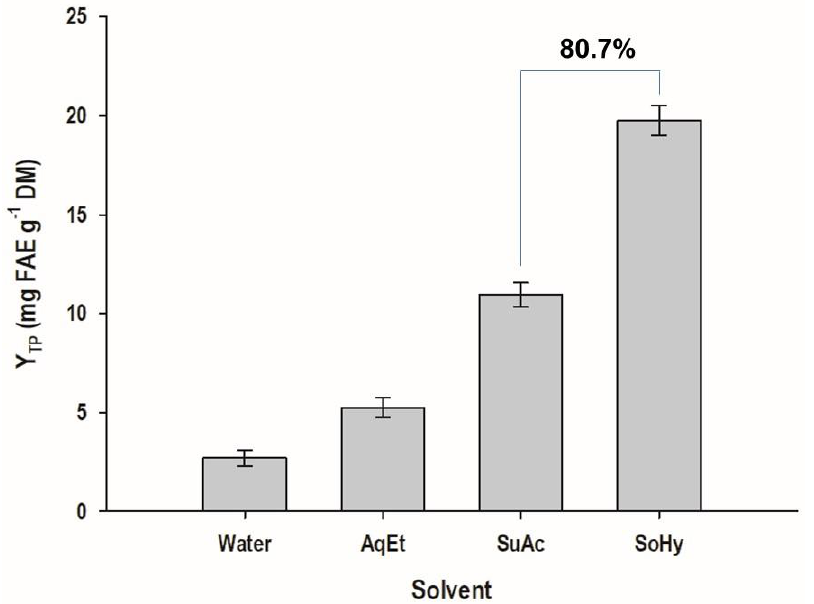
Figure 6. Yield in total polyphenols (Y TP ) achieved after implementing sulfuric acid- and sodium hydroxide-catalyzed treatments of wheat bran, under optimized conditions. Water and aqueous ethanol (AqEt) are control treatments. SuAc and SoHy denote treatments catalyzed by sulfuric acid and sodium hydroxide, respectively.